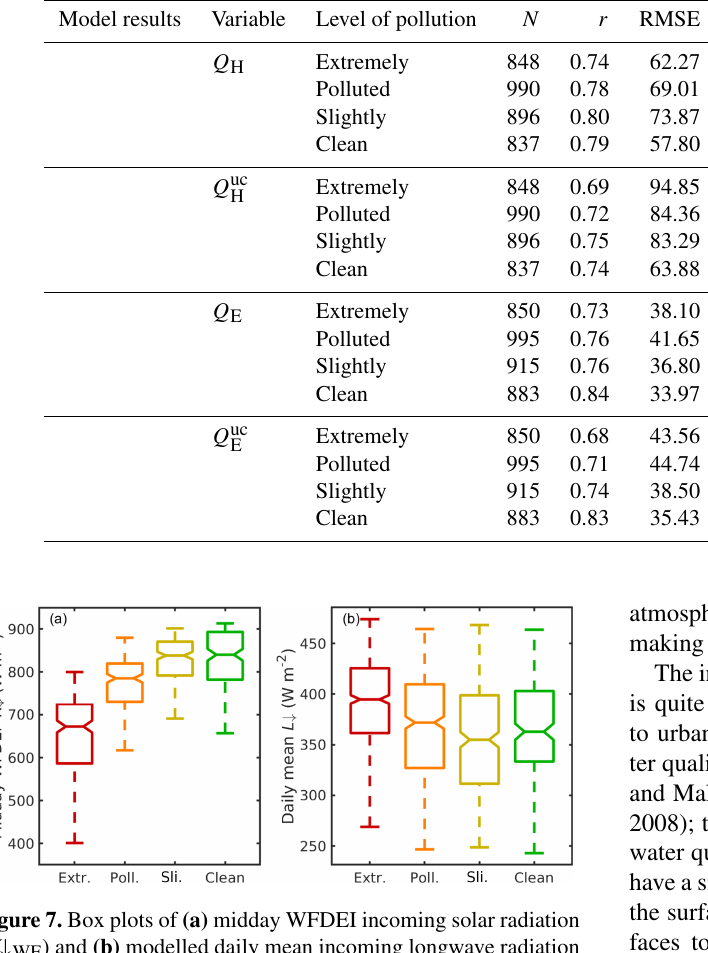
Table 5. Comparison for 2006–2009 of model results with observations, stratified by pollution level (extremely polluted air (AOD > 1),